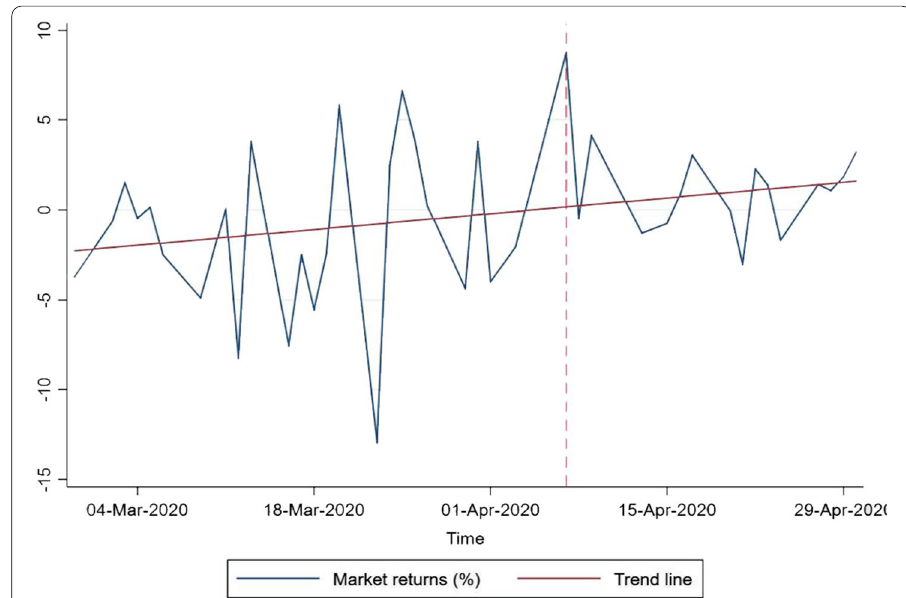
Fig. 1 Market returns around the event. Note : This figure shows the market returns around light a lamp event. The National Stock Exchange (NSE)’s benchmark index, Nifty 50, is used to compute the market returns. The horizontal dashed line indicates the post-event